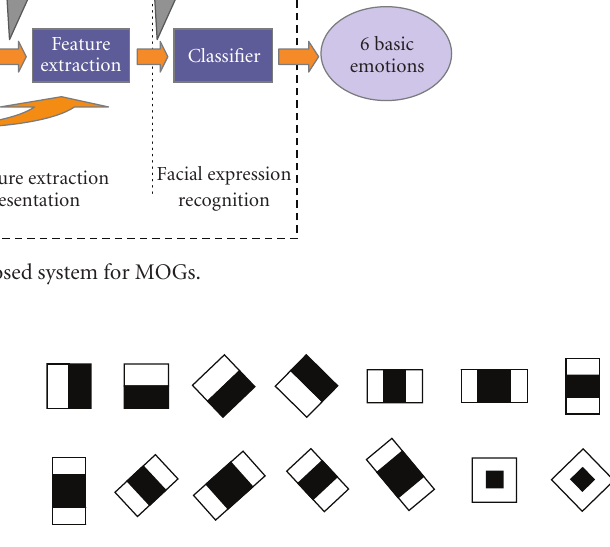
Figure 2: The extended Haar-like feature